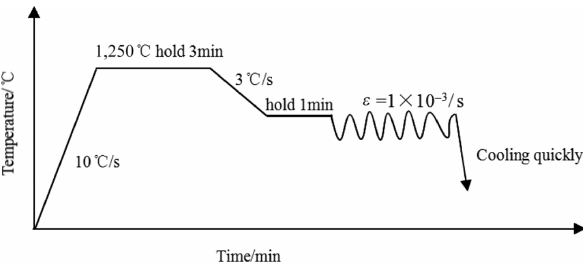
Figure 2: Sketch map of temperature and deformation control during tensile